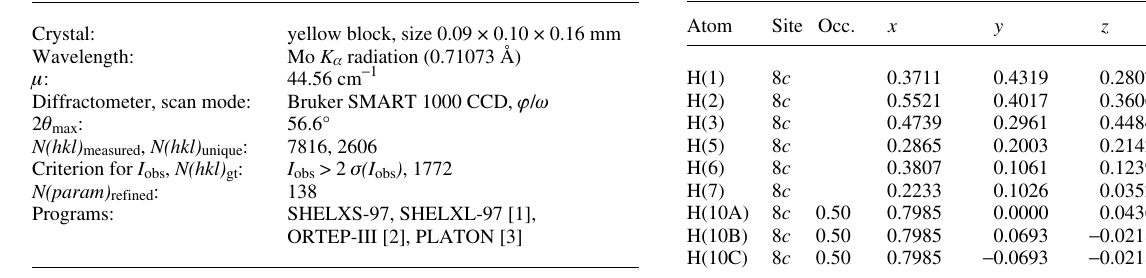
Table 2. Atomic coordinates and displacement parameters (in Å 2 ) . Table 1. Data collection and